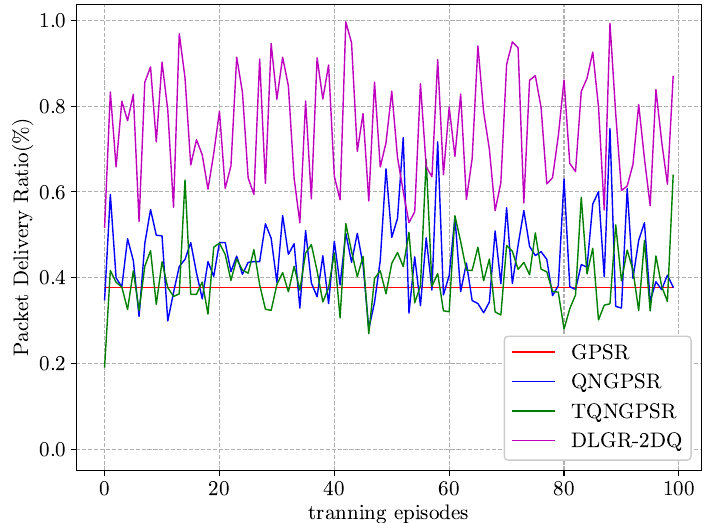
Figure 5. Convergence performance comparison of PDR among TQNGPSR, QNGPSR, and DLGR- 2DQ during the training phase.